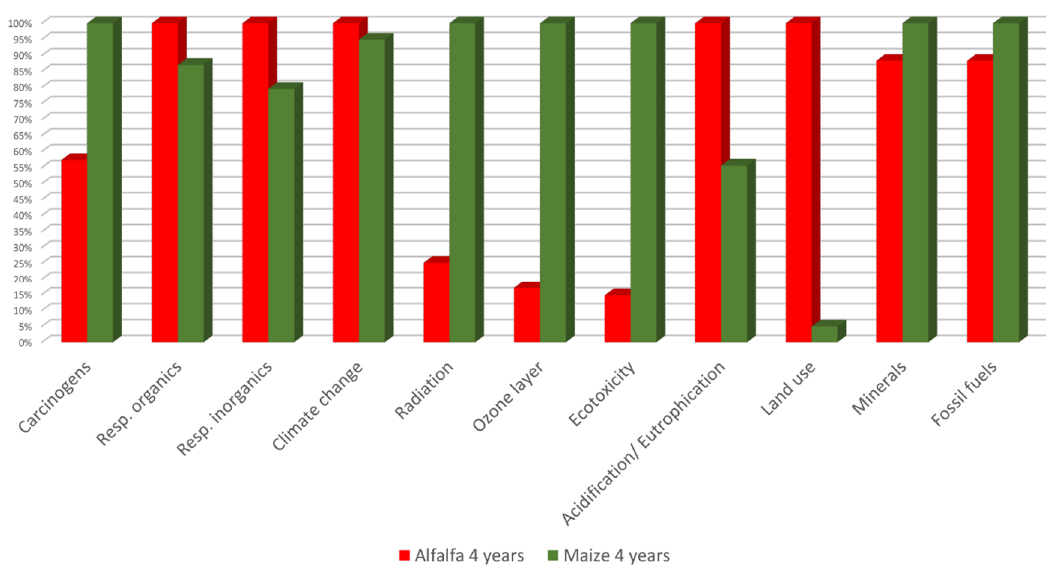
Figure 5. Comparison between the two crops in the characterization phases.